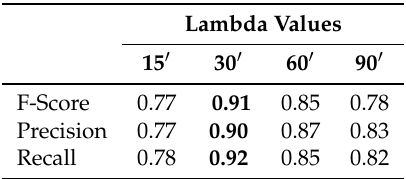
Figure 6. Impact of different λ values on the number of events detected during the day. ( a ) is the UbiqLog dataset and ( b ) is the Device Analyzer (best viewed in color). Table 7. Accuracy of different values for λ